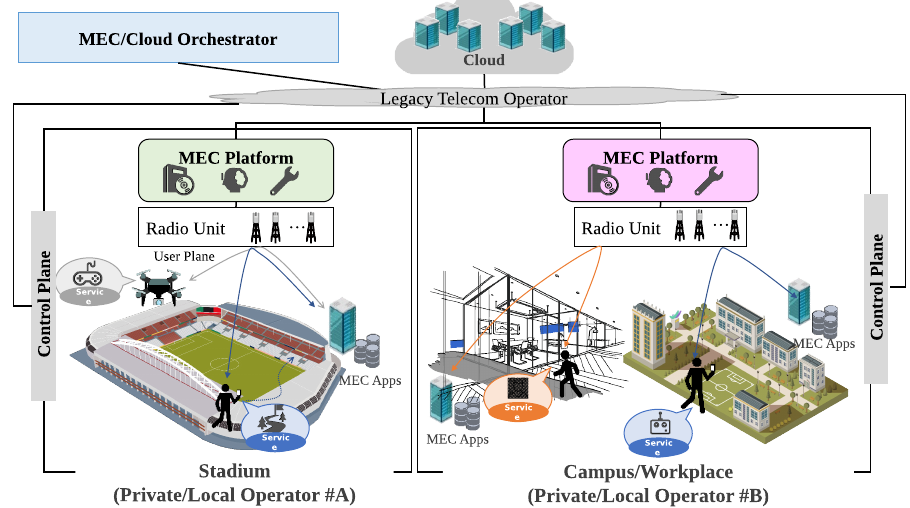
Figure 2. Overview of concept proposal for Private/Local Telecom